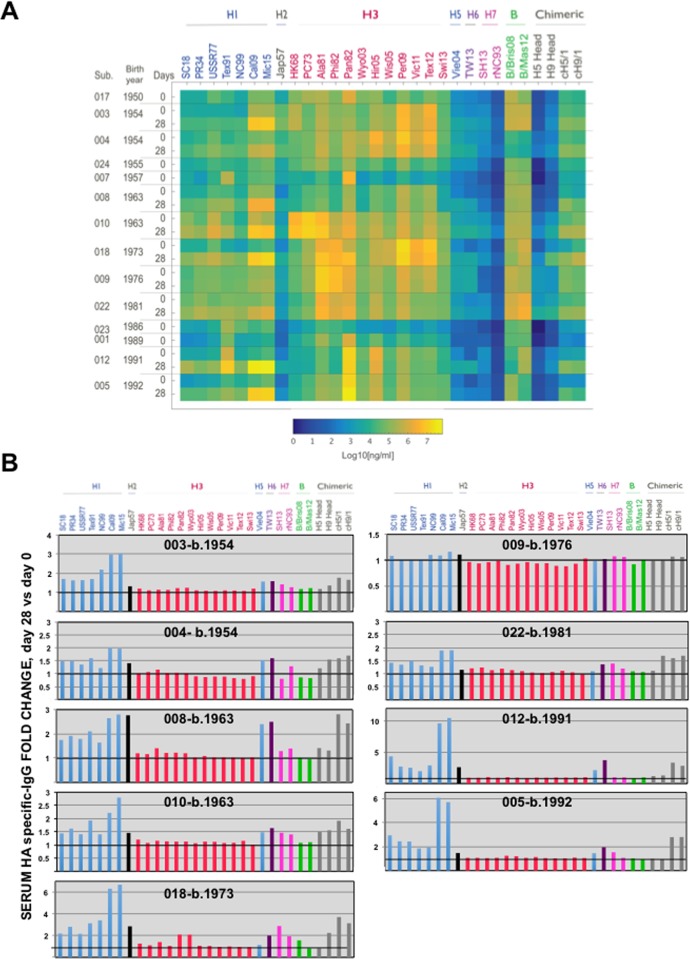
Binding of serum from pH1N1-infected subjects to HA proteins from different strains.(A) Concentrations of sera IgG antibodies cross-reacting to each HA protein were measured by multiplex assay against the indicated IAV and IBV HA proteins. Heatmap showing the average Ab concentrations using two human sera dilutions (1:5,000 and 1:10,000) in duplicates. Subject number, subject year of birth and visit of sera extraction (d0 or d28) are indicated on the left. (B) Graphs representing the fold-change in binding to HA proteins using the sera from day 0, compared to the sera from day 28. Each graph represents one subject. For the HA protein strains: Blue colors represent H1N1 strains (A/South Carolina/1/1918, SC18; A/Puerto Rico/8/1934, PR8; A/USSR/90/1977, USSR77; A/Texas/36/1991, Tex91; A/New Caledonia/20/1999, NewCal99; A/California/04/2009, Cal09; A/Michigan/45/2015, Mic15), black color represents an H2N2 strain (A/Japan/305/1957, Jap57), pink colors represent H3N2 strains (A/HongKong/1/1968, HK68; A/Port Chalmers/1/1973, PC73; A/Alabama/1/1981, Ala81; A/Philippines/2/1982, Phi82; A/Panama/7/1999, Pan99; A/Wyoming/2003, Wyo03; A/Hiroshima/52/2005, Hir05; A/Wisconsin/67/2005, Wis05; A/Perth/16/2009, Perth09; A/Victoria/361/2011, Vic11, A/Texas50/2012, Tex12, A/Switzerland/2013, Swit/2013), blue color represents H5N1 (A/Vietnam/1204/2004, Viet04), purple color represents H6N1 (A/Taiwan/2/2013, TW13), fucsia colors represent H7N9 (A/Shanghai/2/2013, SH13 and H7N1 (A/rhea/North Carolina/39842/93, rhea/NC93), green color represent B (B/Brisbane/60//2008, Bris08; B/Phuket/2013, Phu13), and gray colors represent H5, and H9 head, and chimeric proteins cH5/1 and cH9/1.